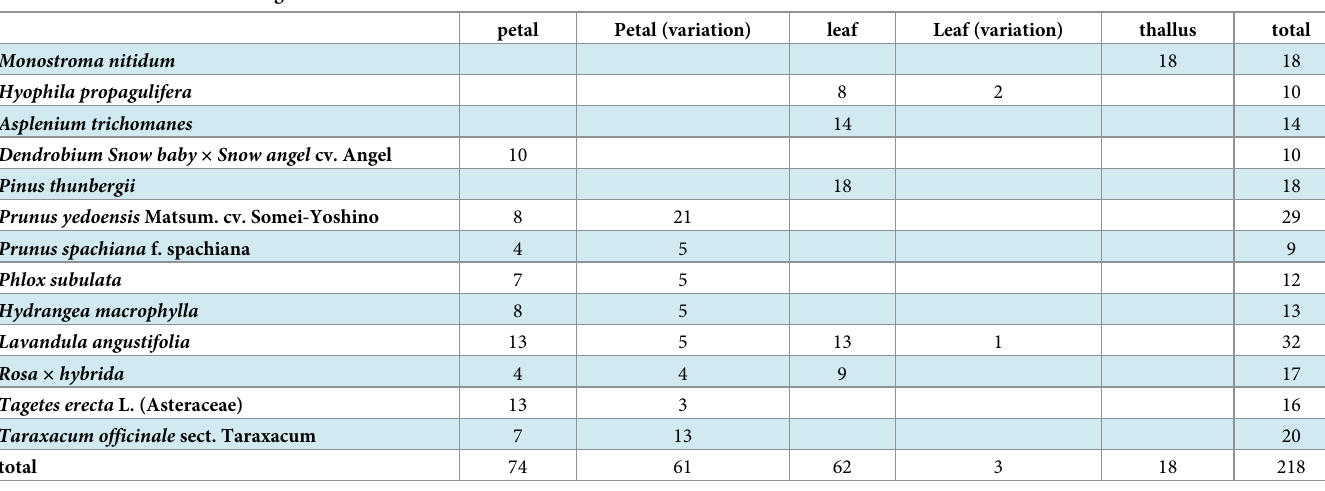
Table 1. Overview of the raw image files.